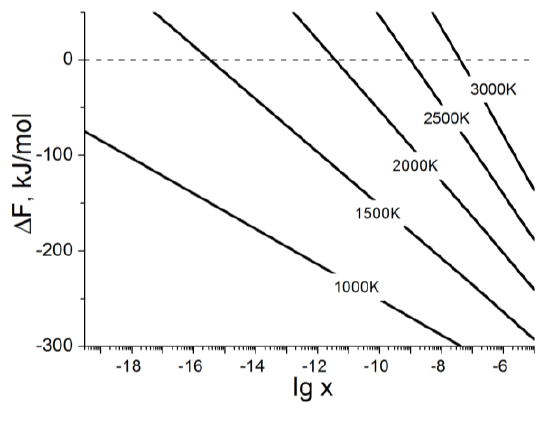
Figure 6. Calculated free energy Δ F of the phase separation within Mo solutions depending on the temperature and Pb content ( x